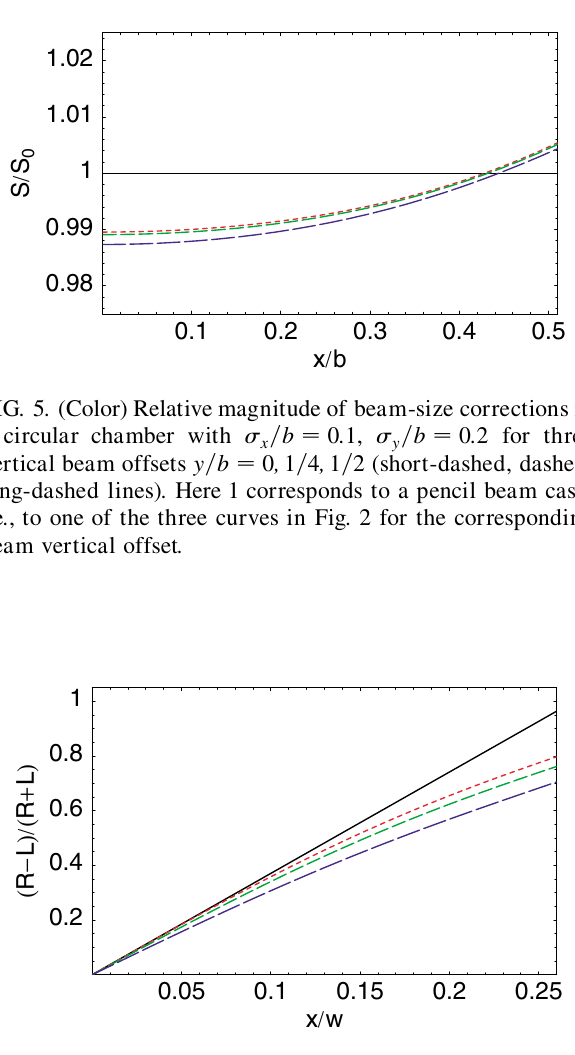
FIG. 6. (Color) BPM signal ratio (25) in a square chamber versus beam center position x=w for three vertical beam offsets y=h (cid:3) 0 ; 1 = 8 ; 1 = 4 (short-dashed, dashed, long-dashed lines) without beam-size corrections (pencil beam, (cid:7) Solid line shows the linear part of the BPM response.